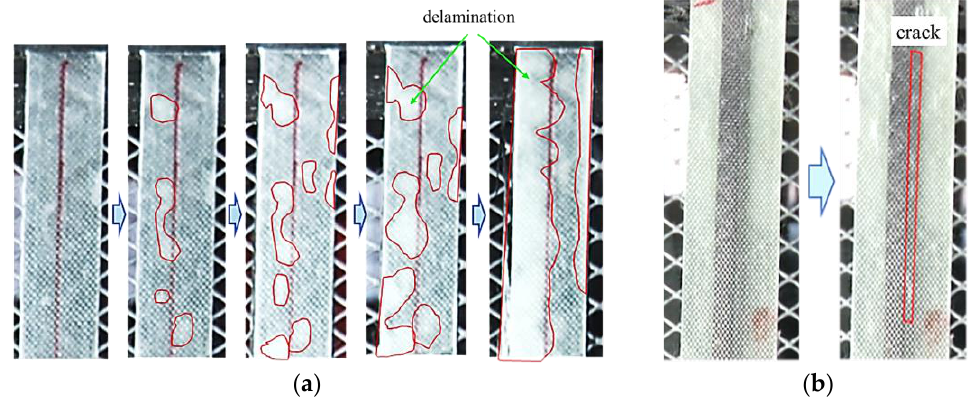
Figure 14. Tensile failure process of hybrid composites: ( a ) the interlayer hybrid structure with C:G = 1:4; ( b ) failure process of intralayer hybrid composites.